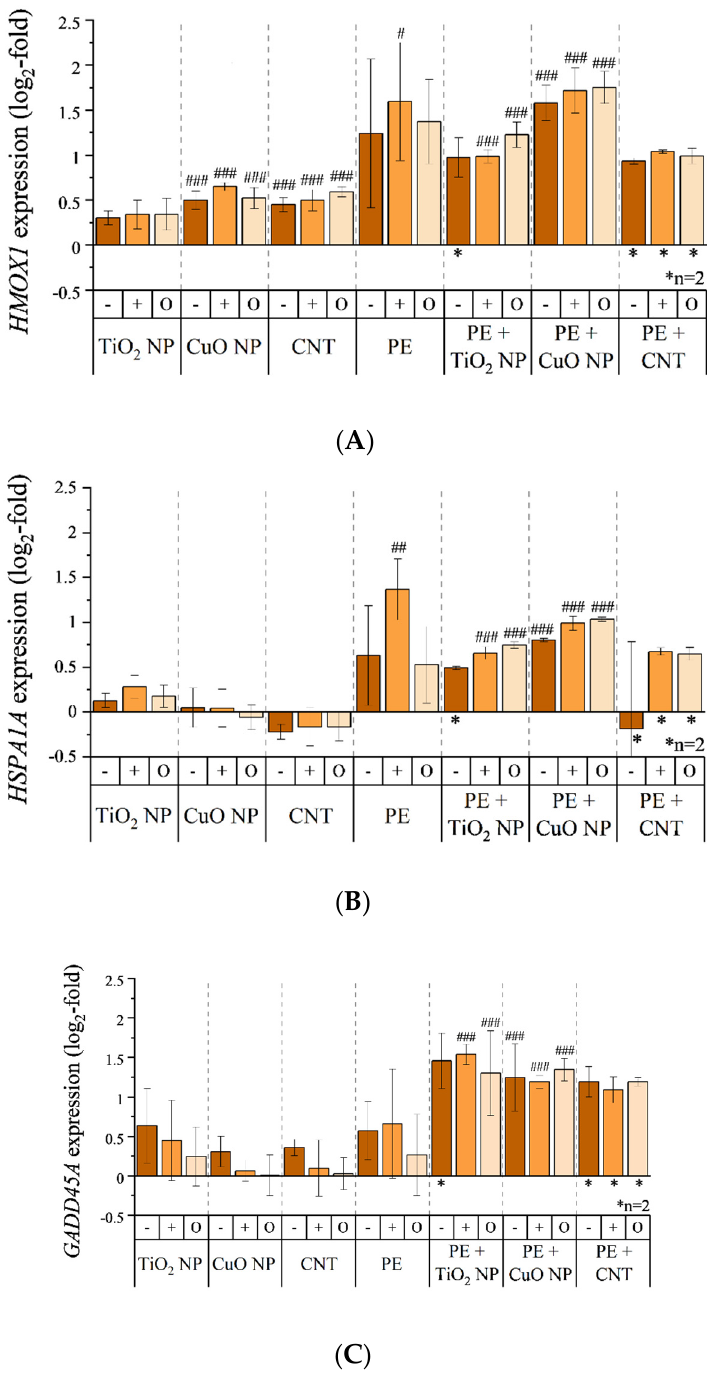
Figure 6. Impact of combustion-generated aerosols on HMOX1 ( A ), HSP1A1 ( B ), and GADD45A ( C ) expression in A549 cells. A549 cells were exposed to aerosols under conditions of normal particle deposition ( − ), increased particle deposition (+), and a filtered aerosol without particle fraction (O) for 4 h, as previously described, and incubated for another 20 h afterward. Thereafter, RNA was isolated and a high throughput RT-qPCR performed. Relative gene expression alterations are depicted as log 2 -fold change. If not stated otherwise (*), mean values of at least three independent experiments ( n = 3) ± SD are shown. Statistically significant by using one-way analysis of variance (ANOVA), followed by post hoc Dunnett's test: # p ≤ 0.05; ## p ≤ 0.01; ### p ≤ 0.001. -: normal aerosol exposure; +: exposure under enhanced particle deposition; O: exposure of a filtered aerosol.